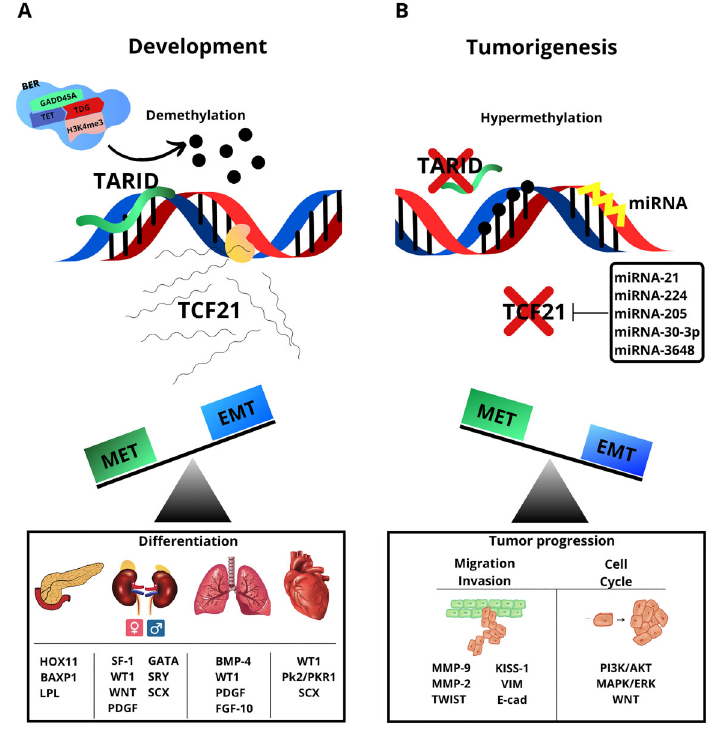
Figure 1. Transcription factor 21 (TCF21) participates in development and tumorigenesis through distinct mechanisms. A , In development, TARID recruits components of the BER demethylation pathway and activates TCF21 expression by inducing promoter demethylation. Expression of TCF21 contributes to mesenchymal-epithelial transition (MET) and embryogenic development/ differentiation of organs through different factors. B , In tumorigenesis, TCF21 is hypermethylated, and silencing by microRNAs (miRNAs) may contribute to epithelial-mesenchymal transition (EMT) and tumor progression. TARID: TCF21 antisense RNA inducing promoter demethylation; BER: TDG dependent base excision repair; GADD45A: growth arrest and DNA damage inducible alpha; TET: ten eleven-translocation family of dioxygenases; TDG: thymine DNA glycosylase and trimethylation of histone H3 at lysine 4